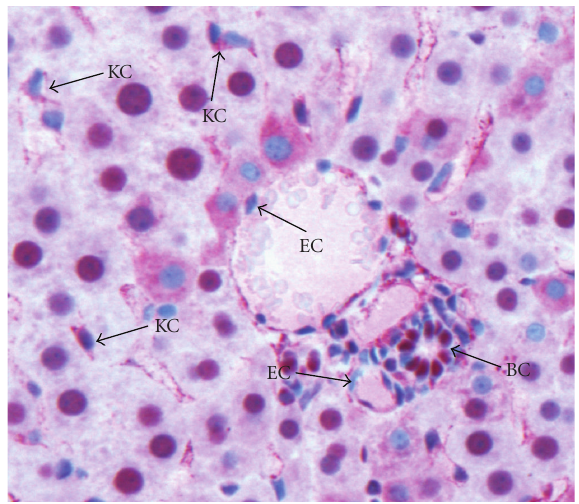
Figure 4: HMGB1-staining patterns in non-parenchymal cells. Kup ff er cells (KCs) presented with weak nuclear staining but strong cytoplasmic staining. Vascular endothelial cells (ECs) were negative for HMGB1, and biliary epithelial cells (BC) were strongly HMGB1 positive during ischemia process